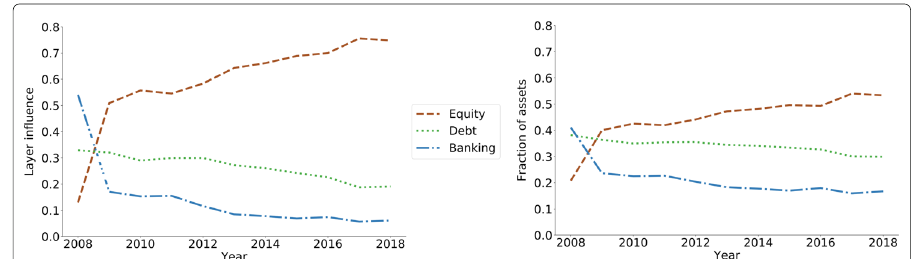
Fig. 4 Layer influence (i.e., MultiRank) z [ α ] and assets in the layers. Temporal evolution of the layers with